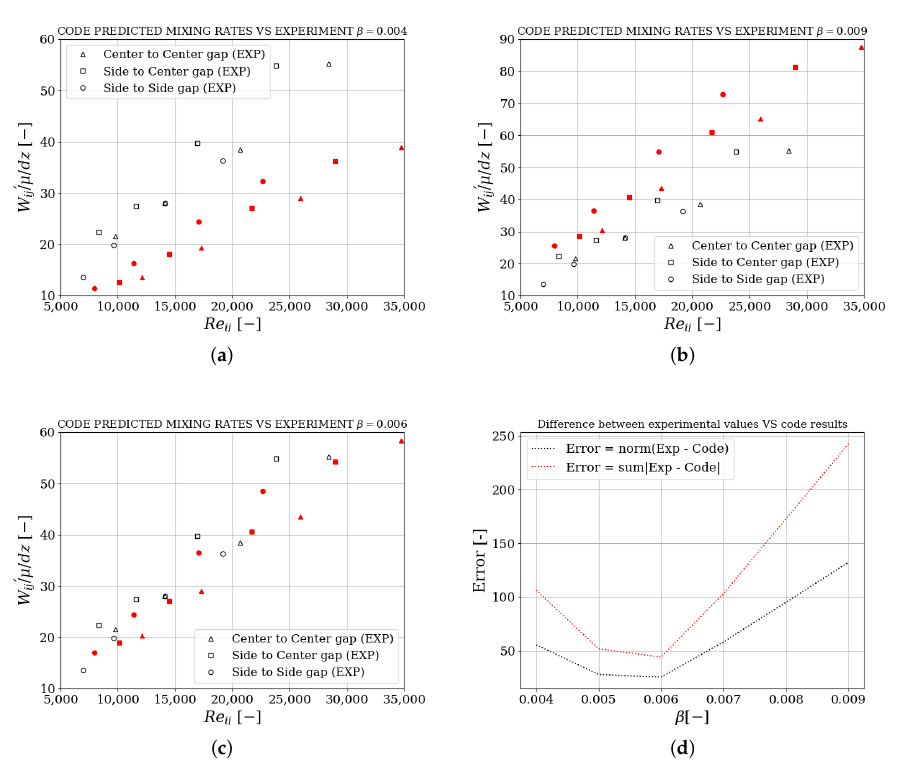
Figure 7. Calibration of β . Code vs. experimental results. ( a ) β = 0.004. ( b ) β = 0.009. ( c ) β = 0.006. ( d ) Error vs. β